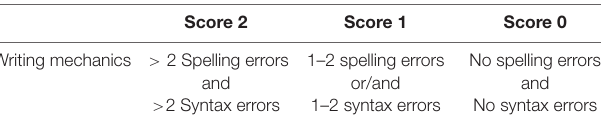
TABLE 4 | Scoring “writing mechanics” of an argumentative